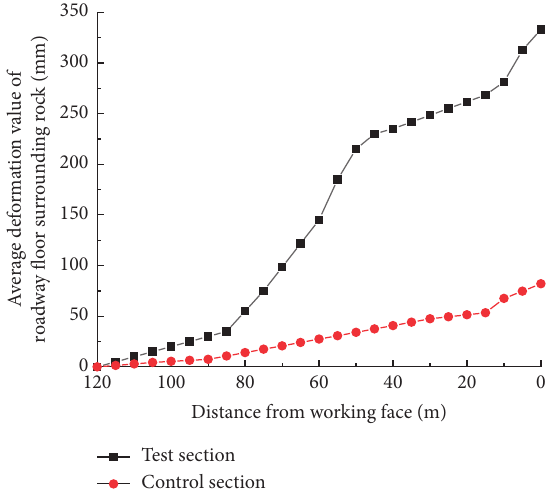
Figure 13: The average deformation curves of 0–2 m floor strata of control section and test